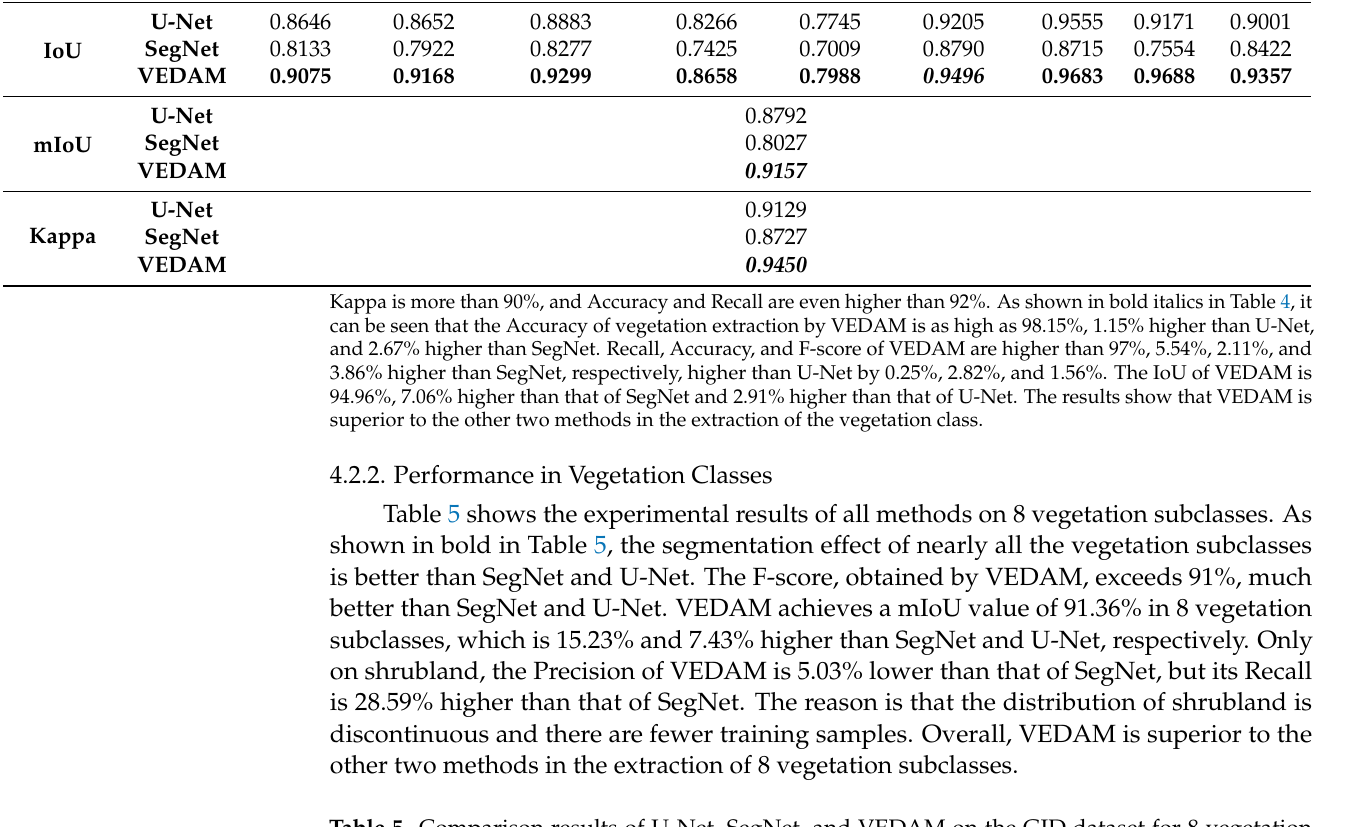
Table 5. Comparison results of U-Net, SegNet, and VEDAM on the GID dataset for 8 vegetation